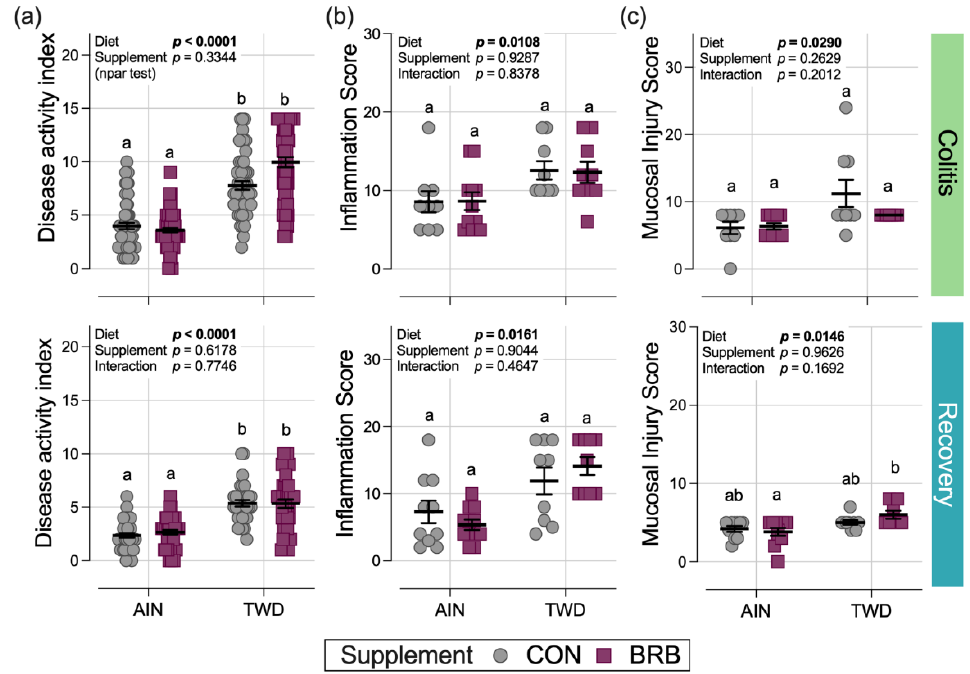
Figure 4. Disease activity index and colon histopathology (experiment B). Scores for the disease activity index (DAI) ( a ), histopathology inflammation score ( b ) and histopathology mucosal injury score ( c ) are shown for active colitis on day 33 and recovery from gut injury on day 45. Data are shown as individual values with mean ± SE. Inset tables provide the statistical model main effects for diet, treatment and their interaction or “npar test” if a non-parametric test was required, and different letters indicate that experimental groups are significantly different ( p < 0.05), as determined by statistical methods outlined in the Materials and Methods section.